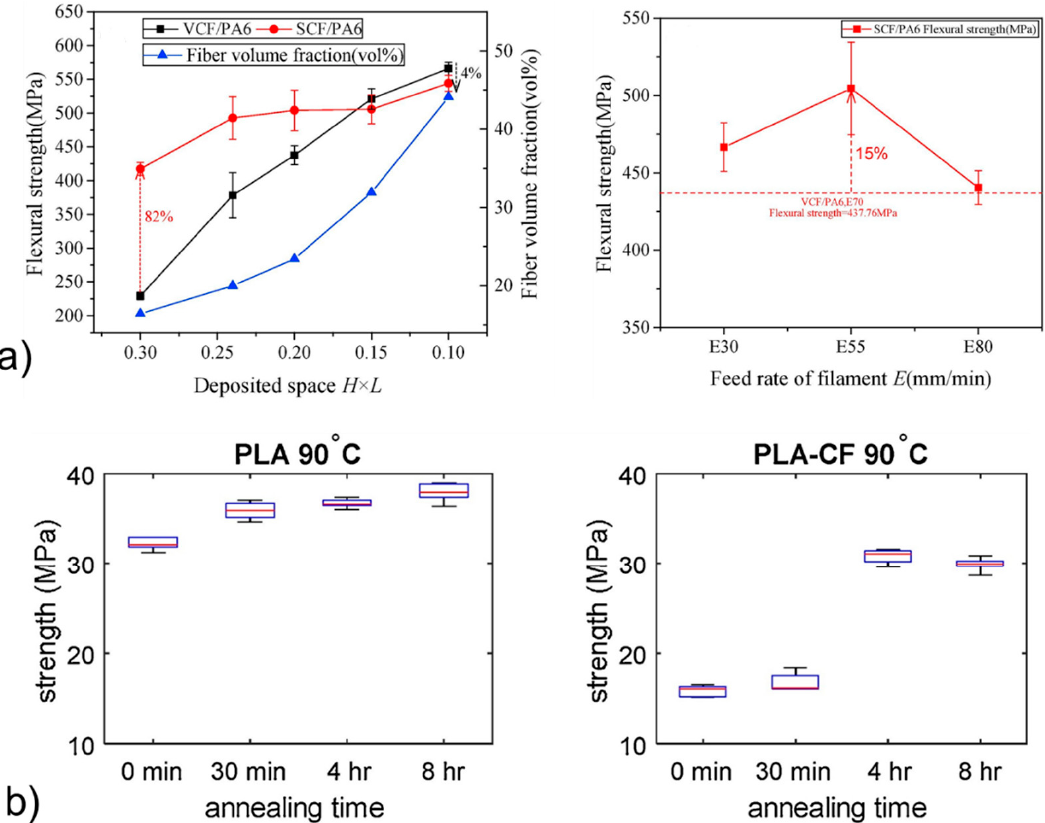
Figure 5. ( a ) Effect of printing parameters, sizing, and fiber fraction on the mechanical strength of 3D printed PA composite [19] (copyright (2018), with permission from Elsevier) and ( b ) effect of annealing on the mechanical strength of 3D printed PLA [20] (copyright (2019), with permission from Elsevier).